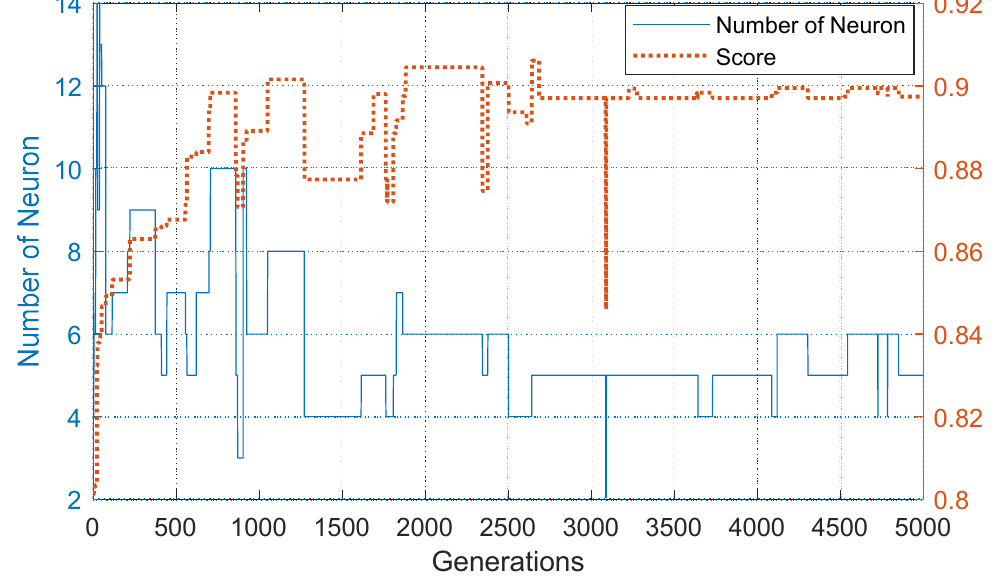
Figure 7. Auto-design process of DNN using NAS.